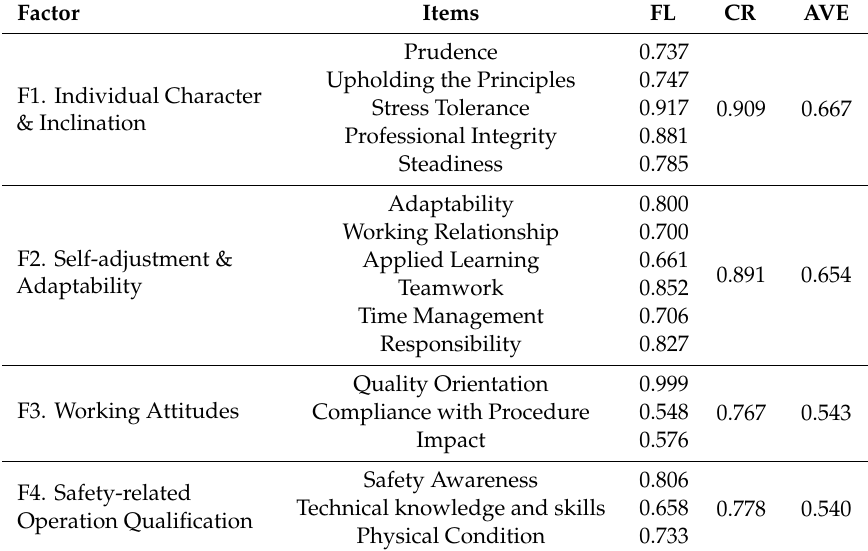
Table 8. The convergent validity test of identified factors.